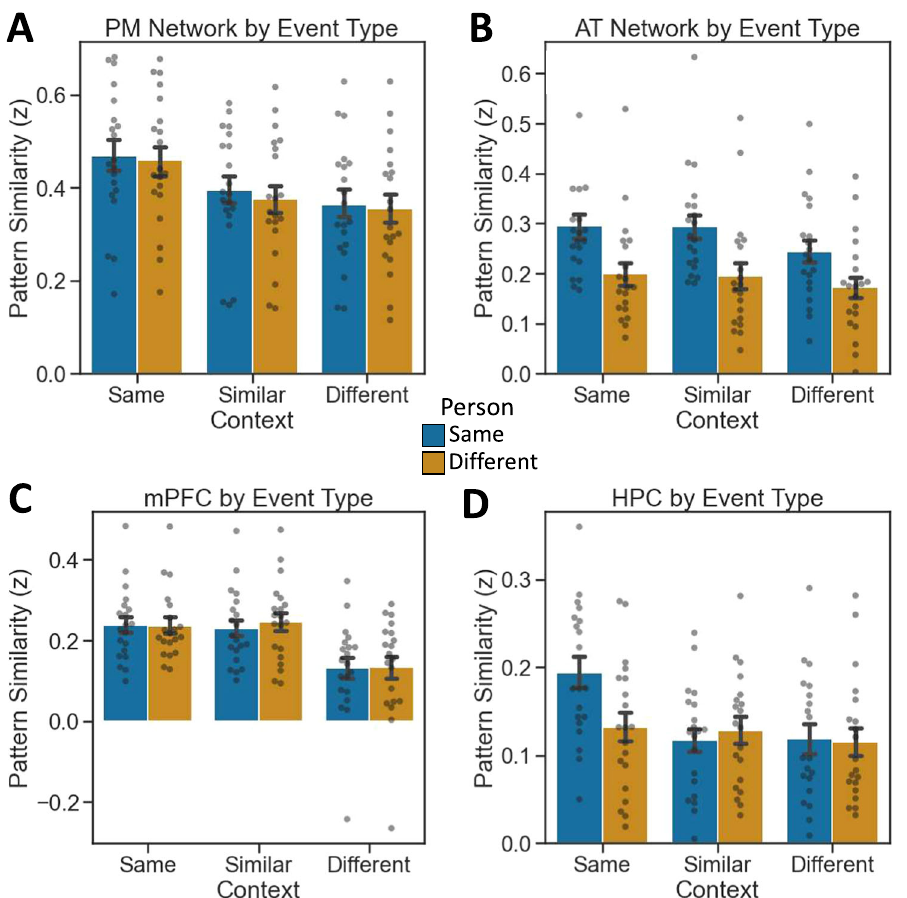
Fig.4|Encodingpatternsimilarityresultsbyeventtype.A PMNetworkpatterns show context-speci fi city. B AT Network patterns show person-speci fi city. C mPFC